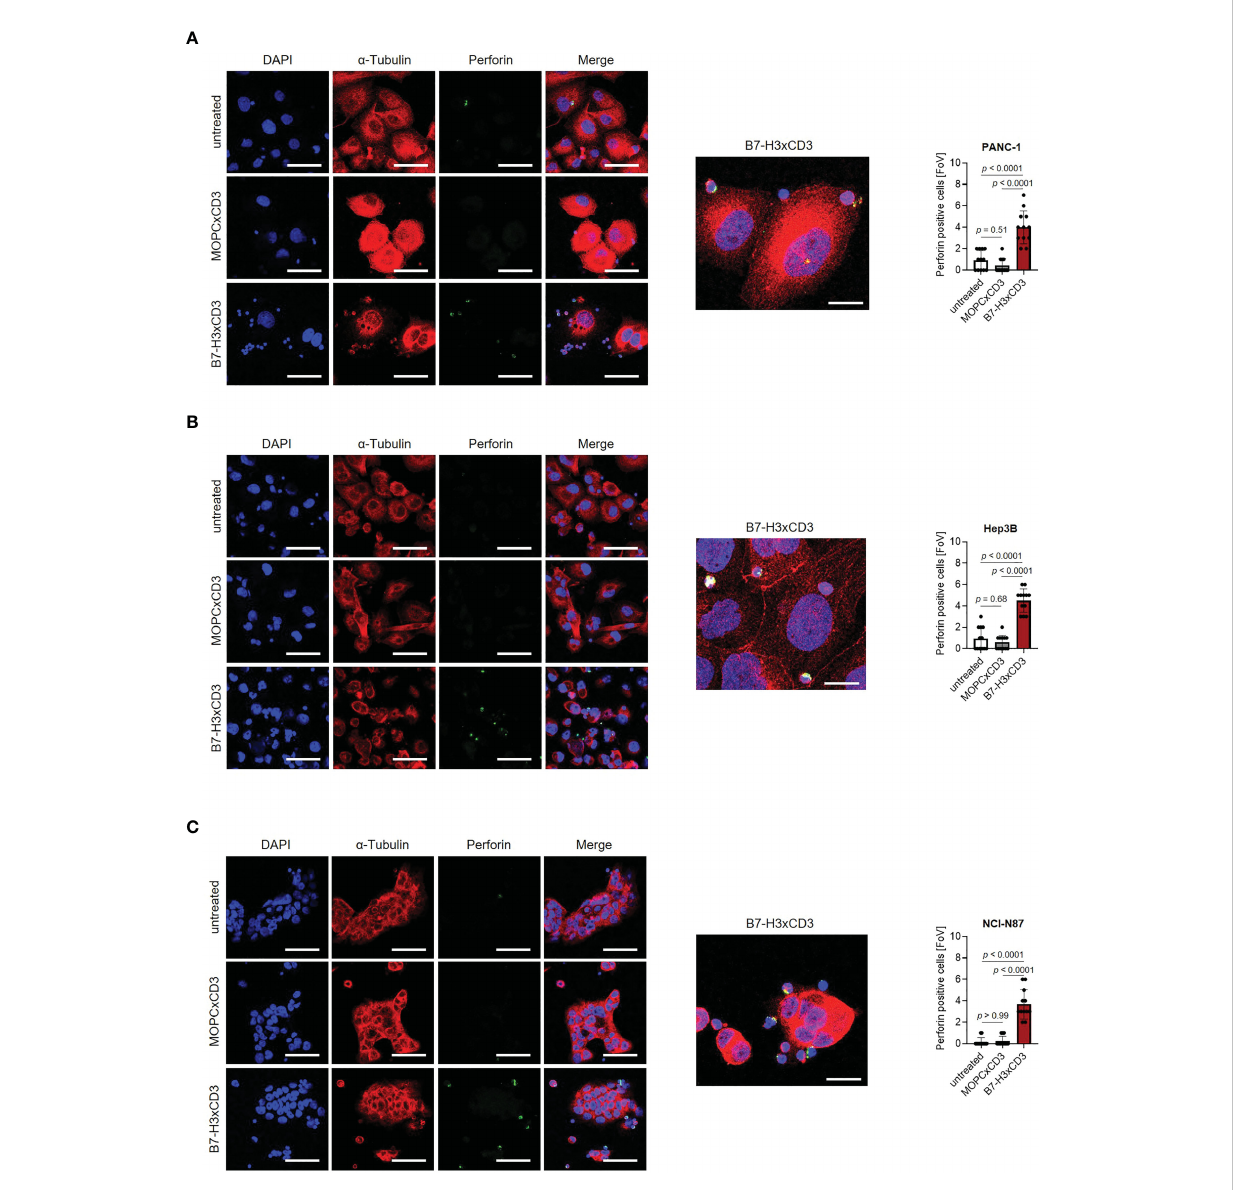
FIGURE 3 Induction of Perforin by CC-3. Monocyte-depleted PBMC of healthy donors were incubated with target cells (E:T 4:1) in the presence or absence of CC-3 or MOPCxCD3 (1 nM each) for 3 hours and subsequently stained for Perforin (green) and a -Tubulin (red). DAPI was used for counterstaining. Scale bars of left panels indicate 50 µM, original magni fi cation x40. Scale bar of exemplary immuno fl uorescence staining indicates 20 µm, original magni fi cation x63. Perforin positive cells were quanti fi ed per FoV (n=12) out of three independent experiments. Results obtained with (A) PANC-1, (B) Hep3B and (C) NCI-N87 cells are shown. DAPI, 4 ′ ,6-diamidino-2-phenylindole; E:T, effector to target; FoV, fi eld of